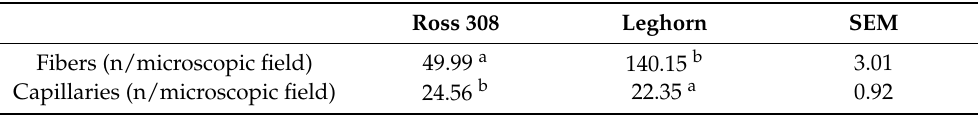
Table 3. Number of fibers per microscopic field and average number of capillaries per microscopic field.